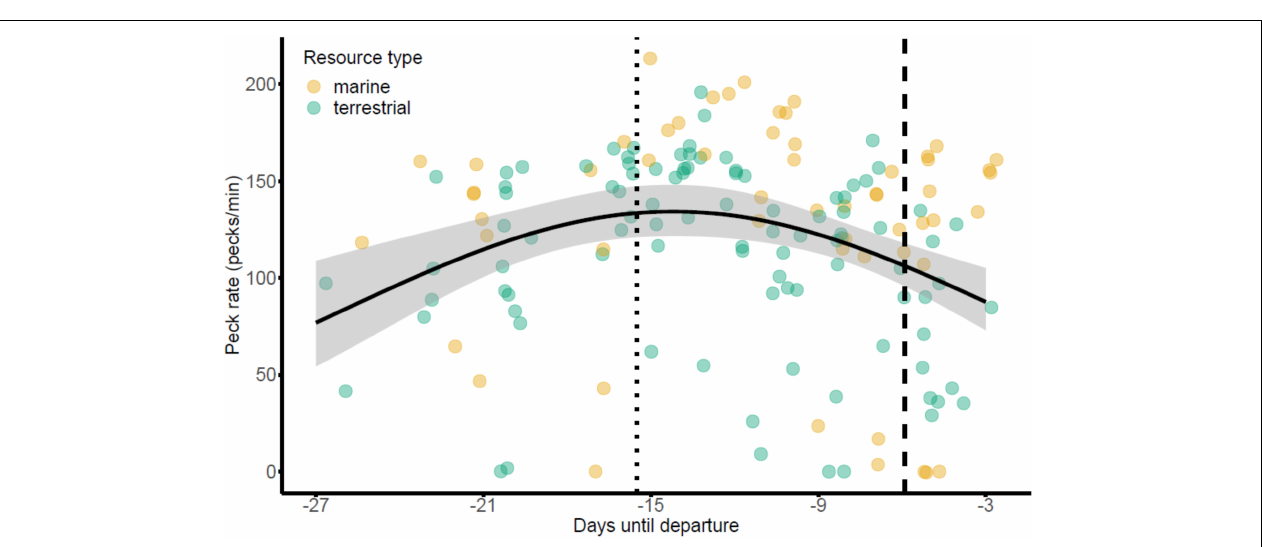
FIGURE 2 | Relationship between peck rates and days until mass departure of light-bellied brent geese from their spring staging site in Álftanes, Iceland. The resource type being fed on during focal observations is coloured as either yellow for marine (saltmarsh) or green for terrestrial (grassland) resources. The black line depicts the quadratic effect of date on peck rates and grey shading represents the standard error. The dotted line is the point of inflection, when the rate of weight gain begins to slow ( x = 14–15/05/17). The dashed line represents the trough in the second derivative of the sigmoidal function, when the rate of weight gain begins to attenuate ( x =